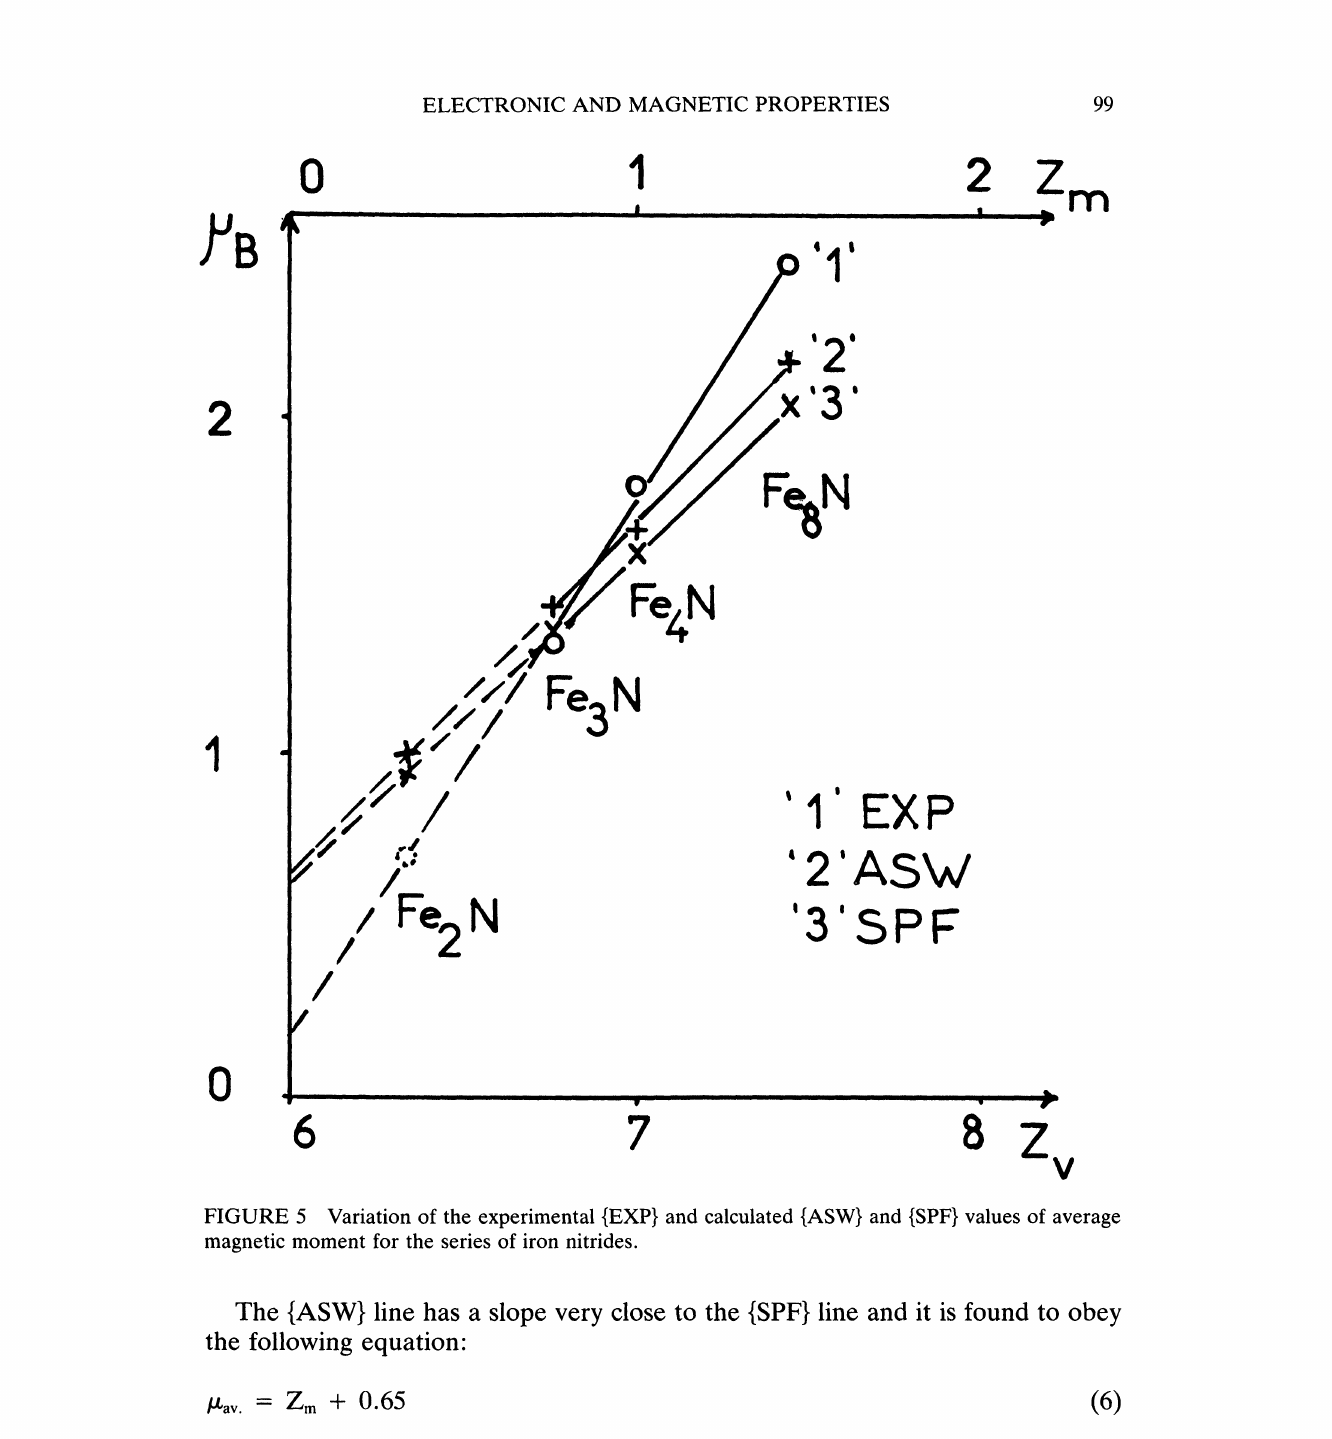
FIGURE 5 Variation of the experimental {EXP} and calculated {ASW} and {SPF} values of average magnetic moment for the series of iron